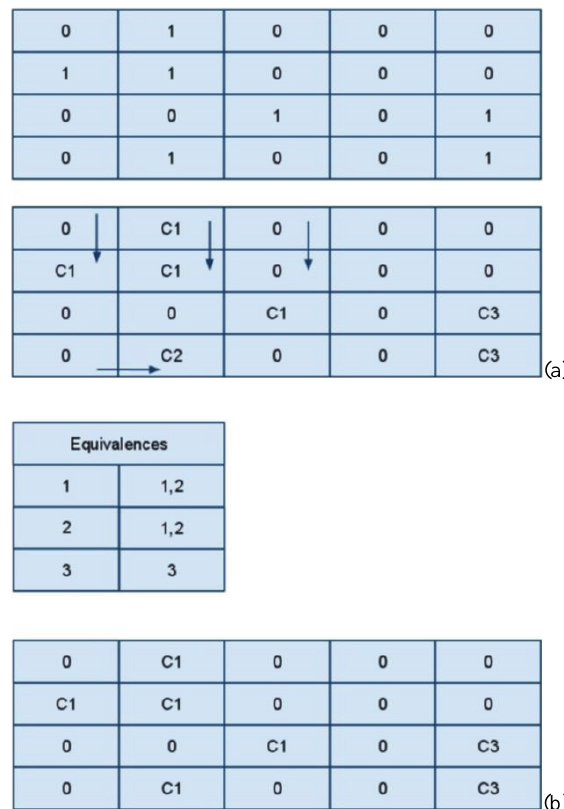
Fig. 5. Example of the steps for linking neighbours in a drought cluster (for detailed explanations see Sect. 2.2.2). (a) Step 1 and (b) Step